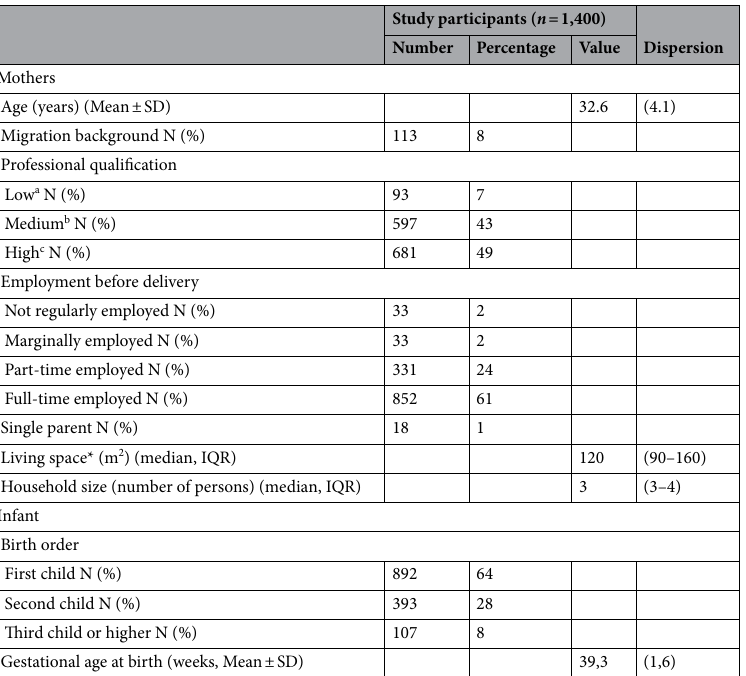
Table 1. Characteristics of the study population. a Secondary/elementary education. b Intermediate education. c University entrance level/tertiary education. *Total living space in the household.